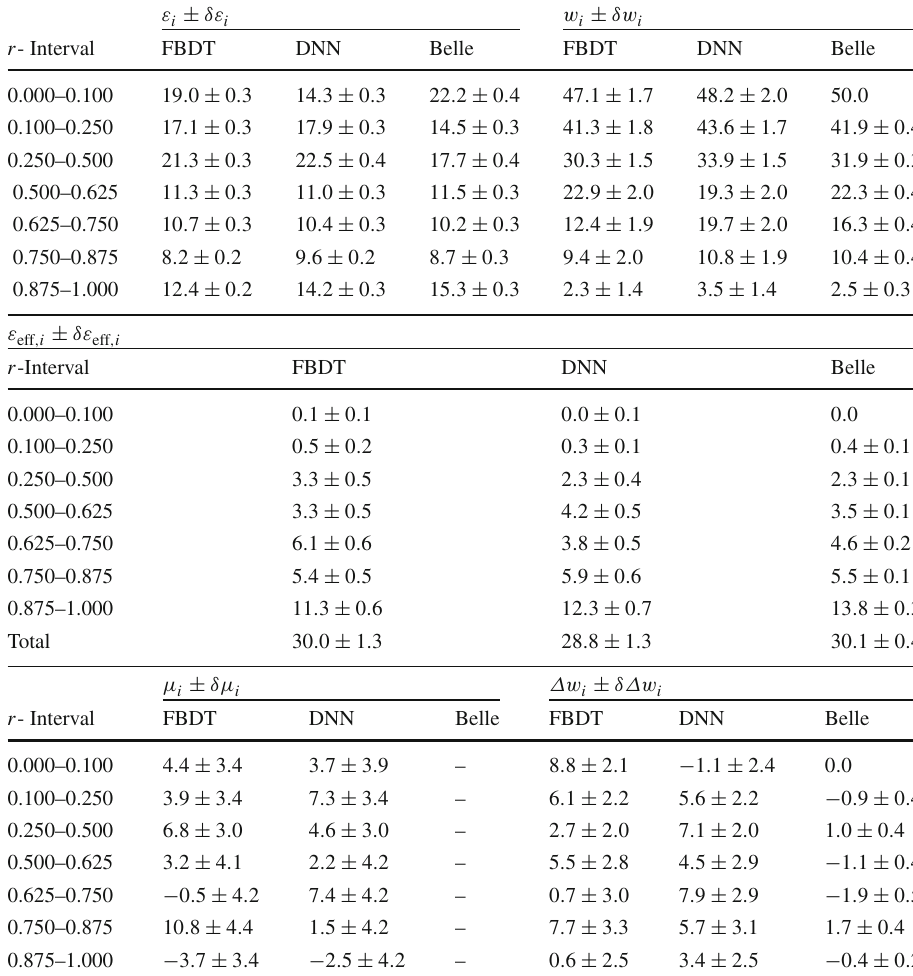
Table 9 Partial efficiencies ε i , wrong-tag fractions w i , total effective efficiencies ε eff , i , tagging efficiency asymmetries μ = Δε/( 2 ε) , and wrong-tag fraction asymmetries Δw obtained with the Belle II category-based (FBDT) and deep-learning (DNN) flavor taggers in 2019–2020 Belle II data and with the Belle flavor tagger in 2003–2010 Belle data [33] taken with the second silicon-vertex detector configuration (SVD2). There are no available Belle results for μ . Statistical and systematical uncertainties are added in quadrature. All values are given in